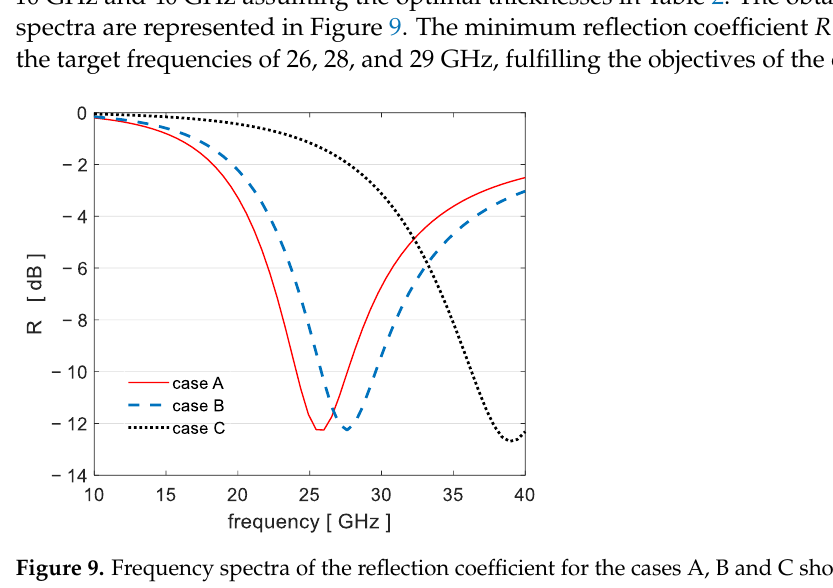
Figure 8. Real ( a ) and imaginary ( b ) parts of input impedance as function of 𝑑 1∗ ( d 2 ) at a frequency of 26 GHz.